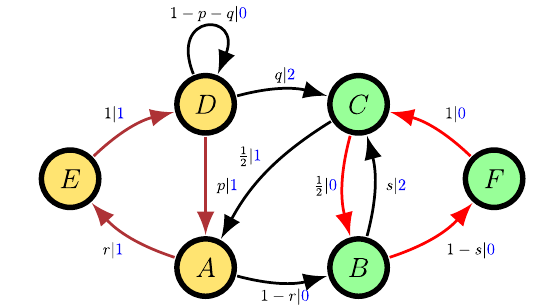
FIG. 1. Hidden Markov model generator of a stochastic process with infinite-range statistical dependencies that requires a HMM with only six states. To generate the same process via a Markov chain requires one with an infinite number of states and so infinite